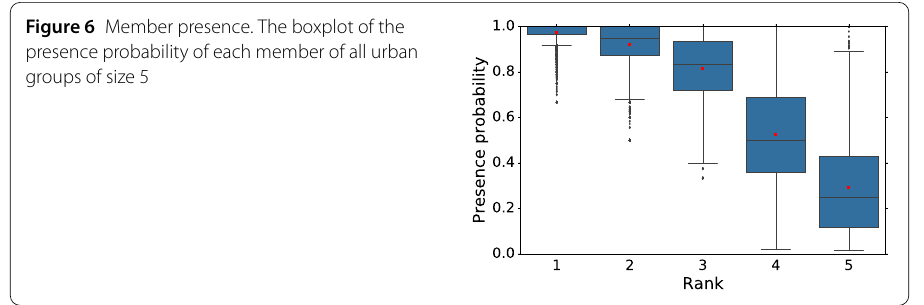
Figure 6 Member presence. The boxplot of the presence probability of each member of all urban groups of size